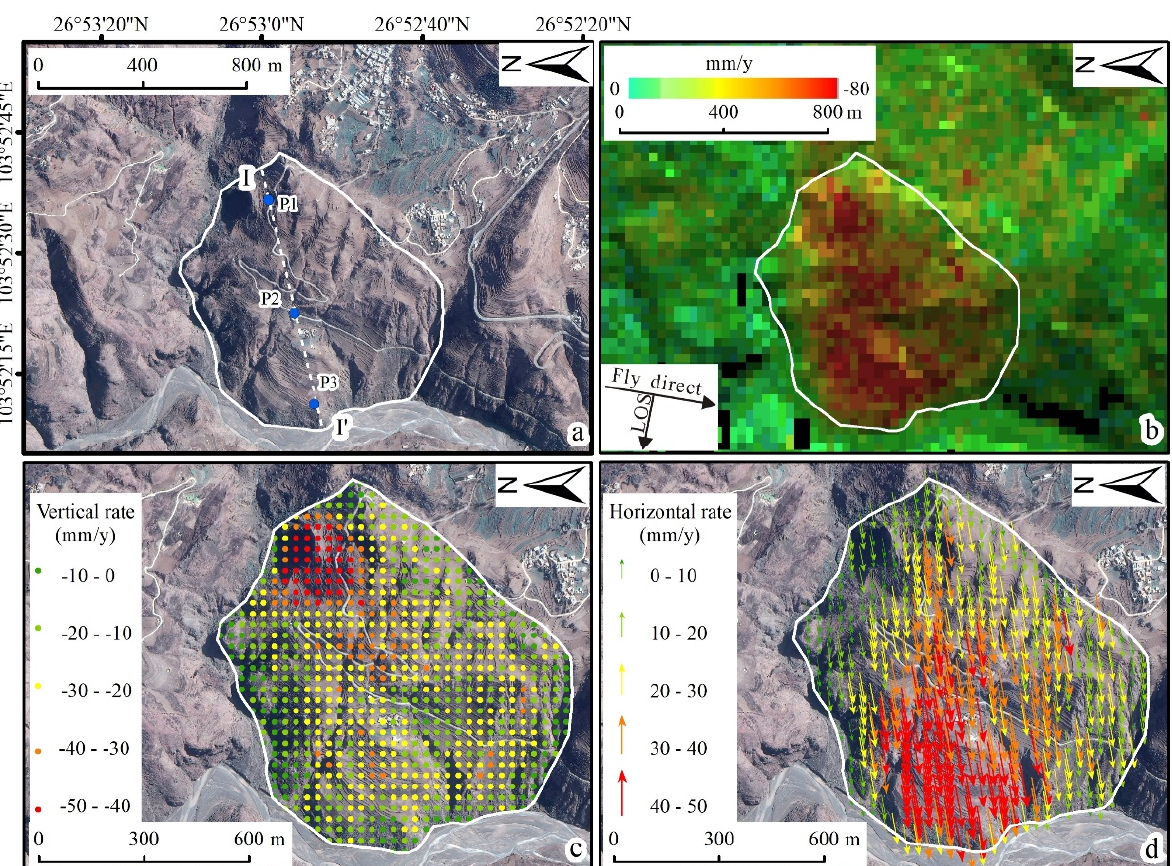
Figure 8. ( a ) Overview of XMT landslide; ( b ) annual average displacement in LOS direction obtained from Sentinel-1 descending images; ( c ) vertical rate; ( d ) horizontal rate.